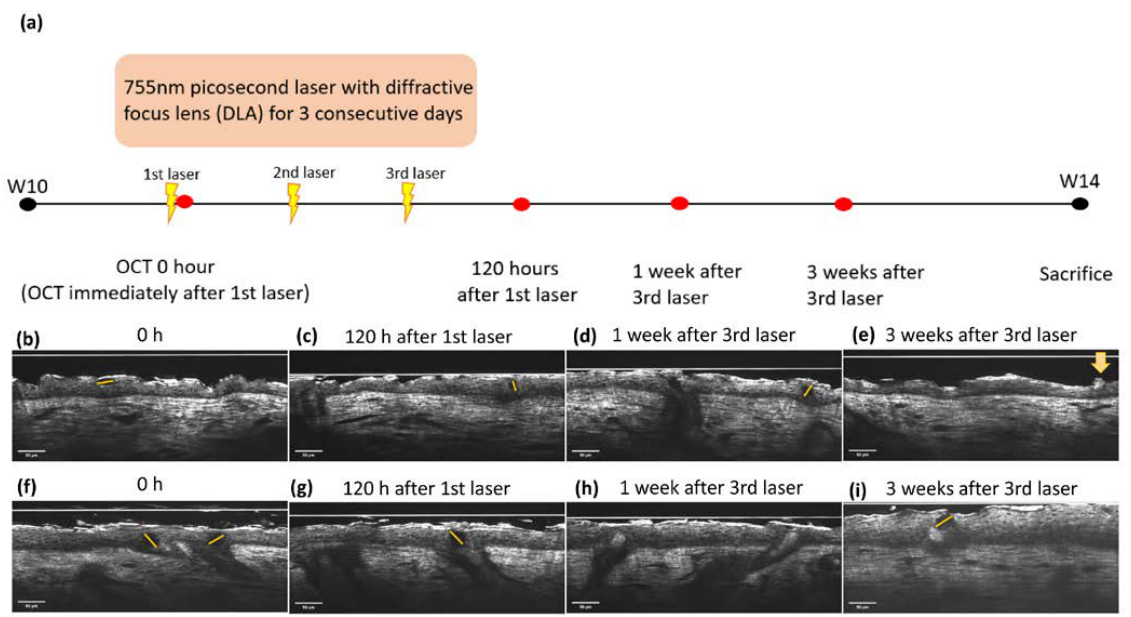
Figure 6. ( a ) Time frame of 755 nm picosecond laser with diffractive lens array (DLA) and OCT scanning for LIOB. LIOB appears as a dark, hypo-reflective vacuole (star) in the epidermis,